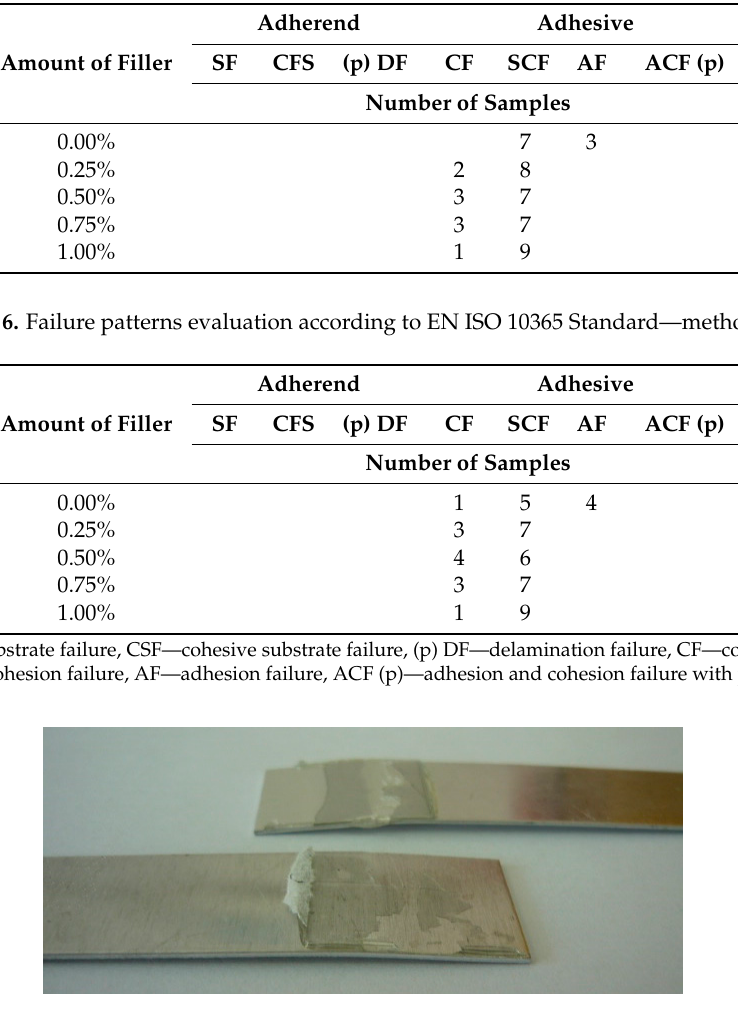
Figure 4. View of adhesive joints after strength test—the view of SCF—special cohesion failure.